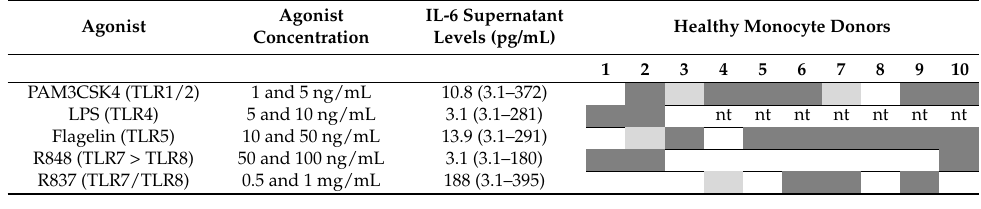
Table 4. The effect of G-CSF on IL-6 release by monocytes derived from 10 healthy individuals. Enriched monocytes were incubated with various TLR agonists (for each individual two different concentrations were tested), and the IL-6 supernatant levels were compared for cultures with G-CSF and corresponding control cultures without G-CSF. The table presents the median and range of the IL-6 concentrations for all 20 cultures with each agonist (i.e., 10 healthy individuals tested with two concentrations of each agonist); control cultures of monocytes incubated in medium alone showed undetectable IL-6 levels. A significant difference was defined as at least a twofold increase/decrease in the presence of G-CSF—at least 20 pg/mL. Divergent effects between the two concentrations of an agonist were not observed for any agonist/donor combination. The dark color indicates a significant G-CSF induced IL-6 increase for at least one of the two agonist concentrations tested, whereas the bright color indicates a significant decrease. Cultures marked with nt means that these were tested with different LPS concentrations (0.1 and 0.5 ng/mL); none of these alternative LPS/donor combinations showed any significant influence of G-CSF on the IL-6 levels. Monocytes cultured in medium alone without G-CSF/TLR agonists showed undetectable IL-6 levels. Agonist IL-6 Supernatant Agonist Concentration Levels (pg/mL)